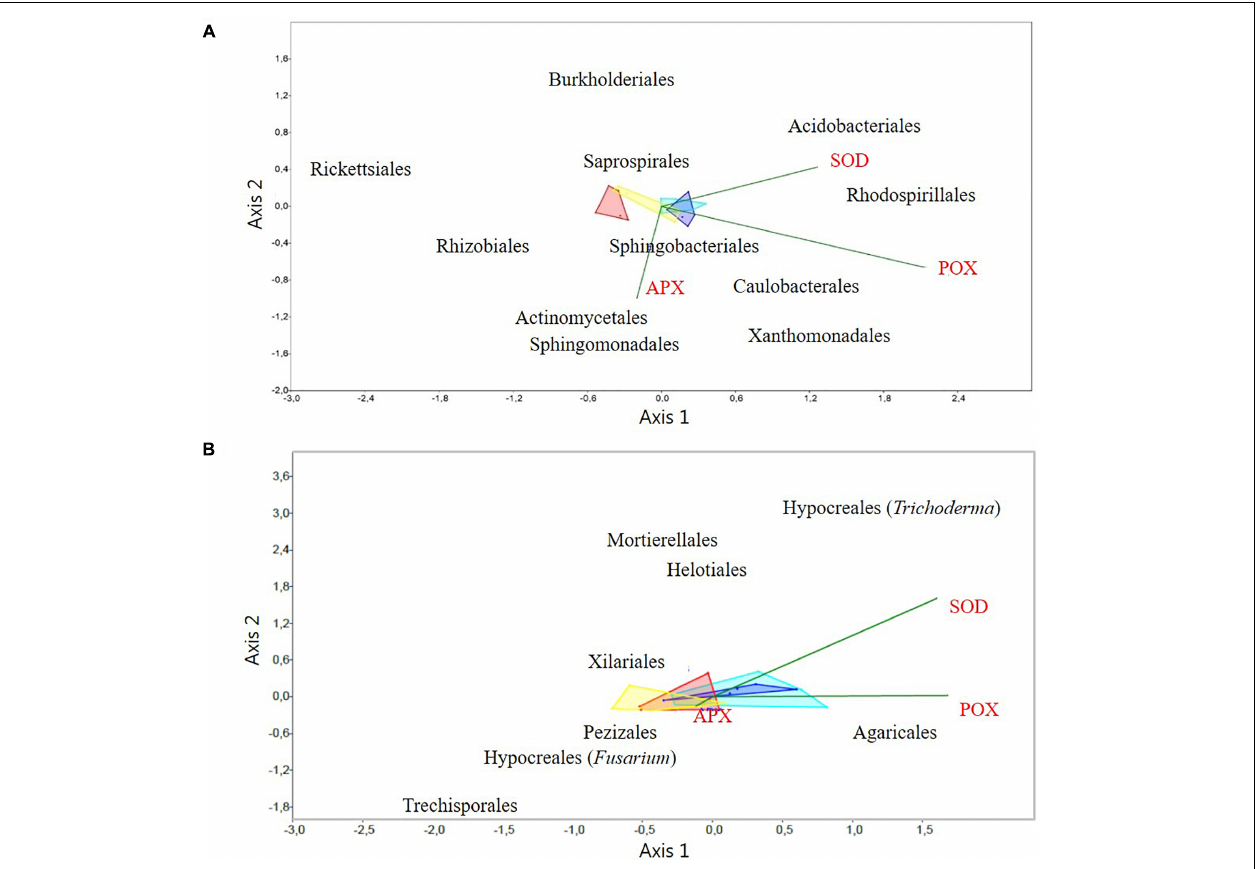
FIGURE 5 | Canonical correspondence analysis (CCA) of activities of antioxidative plant enzymes versus: (A) the relative abundance of rhizosphere bacterial OTUs at the order level, and (B) the relative abundance of rhizosphere fungal OTUs at the order level. Only the discriminatory taxa (according to SIMPER analysis), and enzyme results with significant differences ( P < 0.05): Superoxide dismutase (SOD), Ascorbate peroxidase (APX), and Peroxidase (POX), were included in the CCA analyses. Light and dark blue areas correspond to samples from Germany, from small and tall plants, respectively. Red and yellow correspond to samples from Denmark, from small and tall, plants, respectively. The dark green line vectors represent the direction of the root antioxidant enzymes levels and the bacterial and fungal OTUs